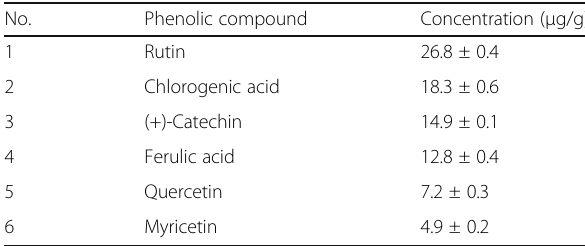
Table 1 Contents of phenolic compounds in DML are analyzed by HPLC method. Among these 6 phenolic compounds, rutin is the highest content and myricetin is lowest in DML. Values are mean ± standard deviation ( n =